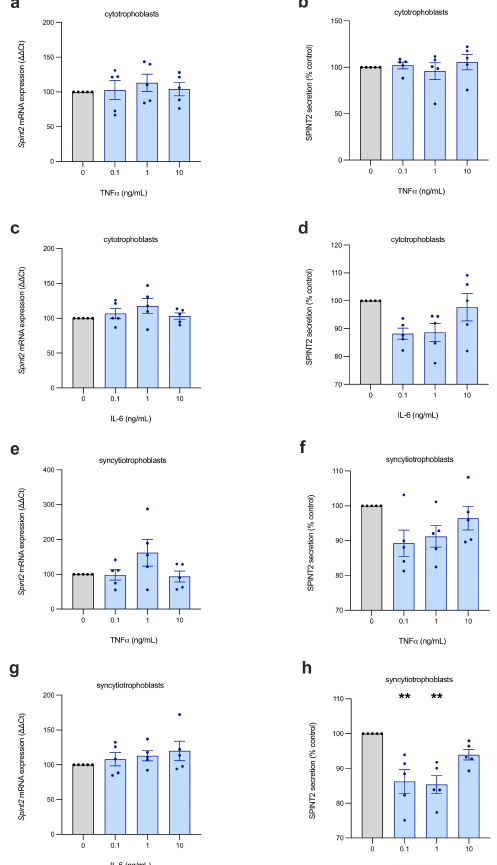
Figure 4. Inflammatory cytokine regulation of SPINT2 in placental cells. First-trimester cytotro- phoblasts ( a – d ) and syncytiotrophoblasts ( e – h ) were treated with inflammatory cytokines, TNF or IL-6, at various doses. No significant changes were observed in SPINT2 mRNA ( a , c , e , g ) expression, nor in secreted SPINT2 ( b , d , f ); with the exception of IL-6–treated syncytiotrophoblasts ( h ), which stimulated a modest, but significant, decrease in SPINT2 secretion at lower doses. Experiments were repeated n = 5 times; data are expressed as mean ± SEM; ** p <